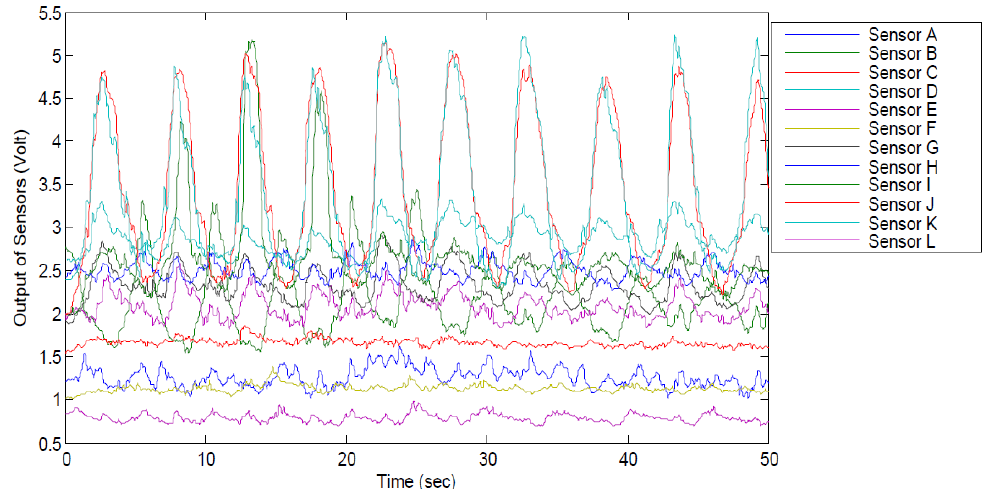
Figure 9. A sample diagram for ten cycles of flexion-extension performed by Participant 2. All sensors’ signals were adjusted to start from 1 V by potentiometers and some sensors were activated.